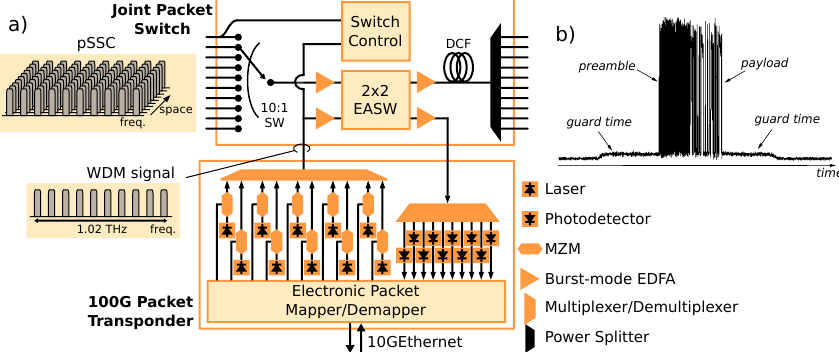
Figure 4. 10 Tb/s cSSC ( a ) Simplified structure of the 1 Tb/s 10-core joining packet switch and 100G packet transponder. ( b ) Trace of a 64 byte 10GEthernet after mapping into one carrier of one pSSC at the 100G packet